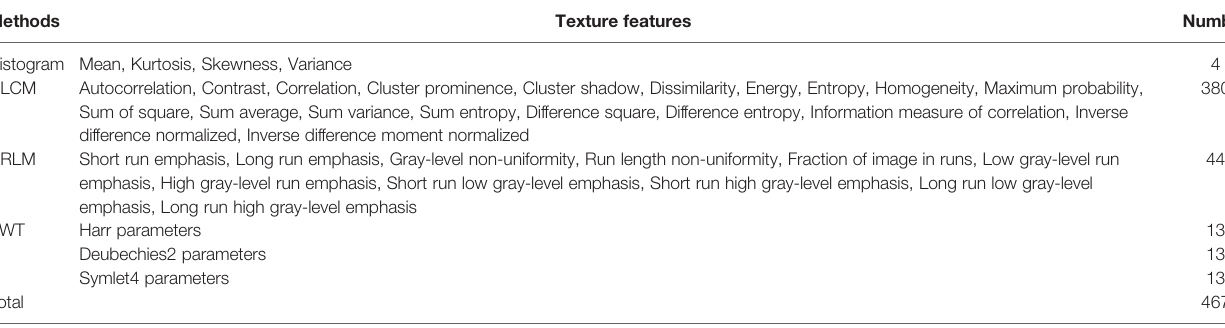
TABLE 2 | Detailed information on the extracted